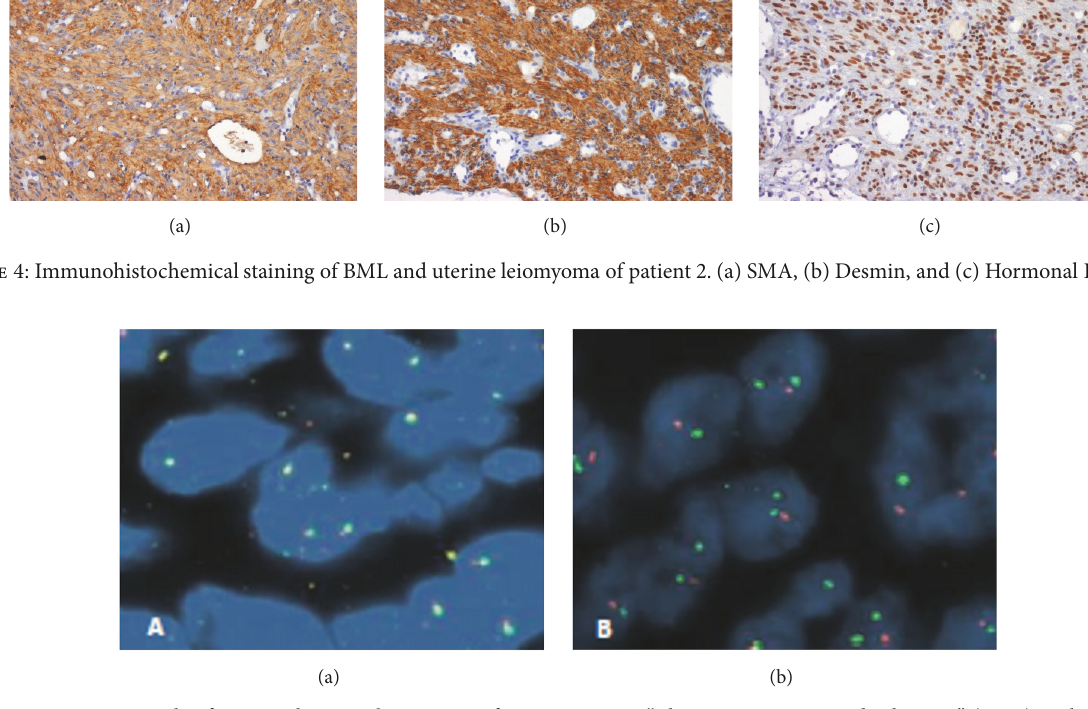
Figure 5: Cytogenetic study of BML and uterine leiomyoma of patient 2, using “ Fluorescence In Situ Hybridization” (FISH), with probes LSI EWSR1 (22q12) Dual Color, Break Apart RearrangementProbe, Abbott , and ZytoLight SPEC 19q13/19q13 Dual Color Probe, Zytovision. (a) 22q12 deletion and (b) 19q13